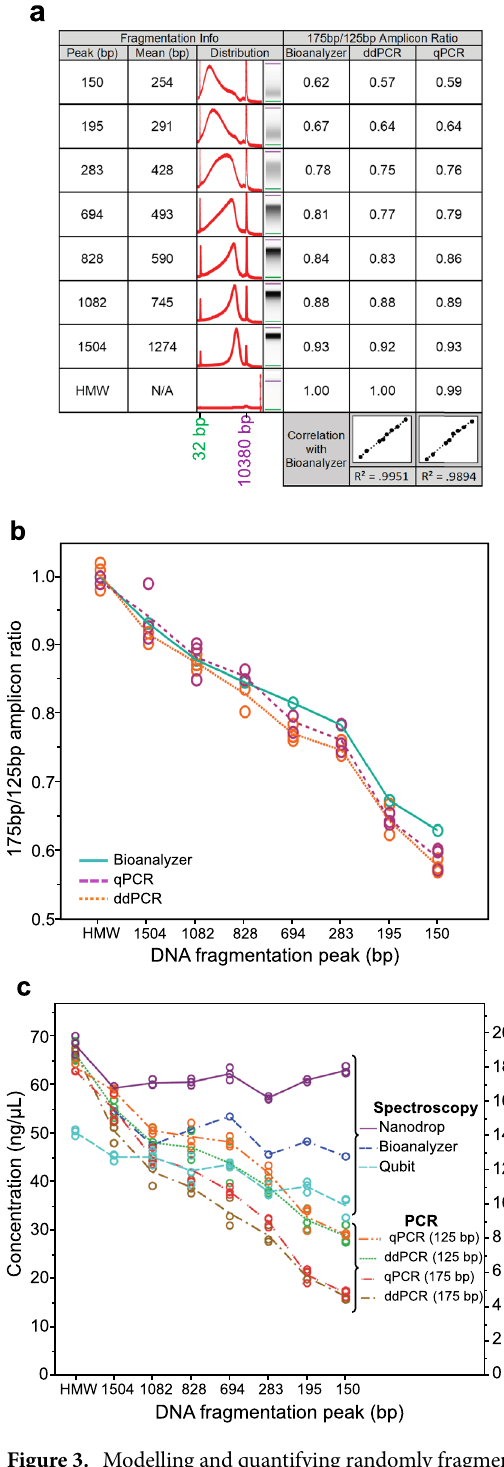
Figure 3. Modelling and quantifying randomly fragmented DNA. ( A ) Table showing DNA samples sonicated to different fragment lengths, their fragment distribution profiles in electropherogram and pseudo-gel form, and comparison between the theoretically (Eq. 3 applied to Bioanalyzer data) and experimentally determined [175 bp]/[125 bp] differential amplicon length ratios. The full unedited pseudo-gel image for these sonicated samples can be found in S6 Fig. ( B ) Line graph plotting the [175 bp]/[125 bp] ratios determined by qPCR, ddPCR, and our mathematical model applied to fragment size distribution data (Bioanalyzer) on differentially fragmented DNA samples. ( C ) Comparison of nucleic acid quantification methods on fragmented DNA. PCR data points are averages of the two universal assays for each amplicon length per well. Fluorometric (Qubit) and absorbance (Nanodrop) spectroscopy measurements were made on each sample on three separate occasions. Spectroscopy concertation measurements are depicted in ng/µl and PCR as copies/µl. Axes are scaled so that 1 copy = 3.5